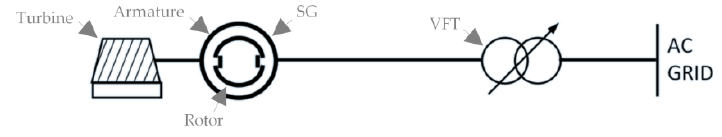
Figure 3. Connection through a VFT.